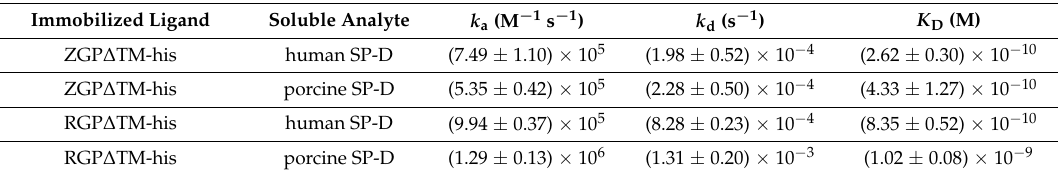
Table 1. Kinetic and dissociation constants for the binding of human and porcine SP-D to immobilized GP from Zaïre and Reston Ebola